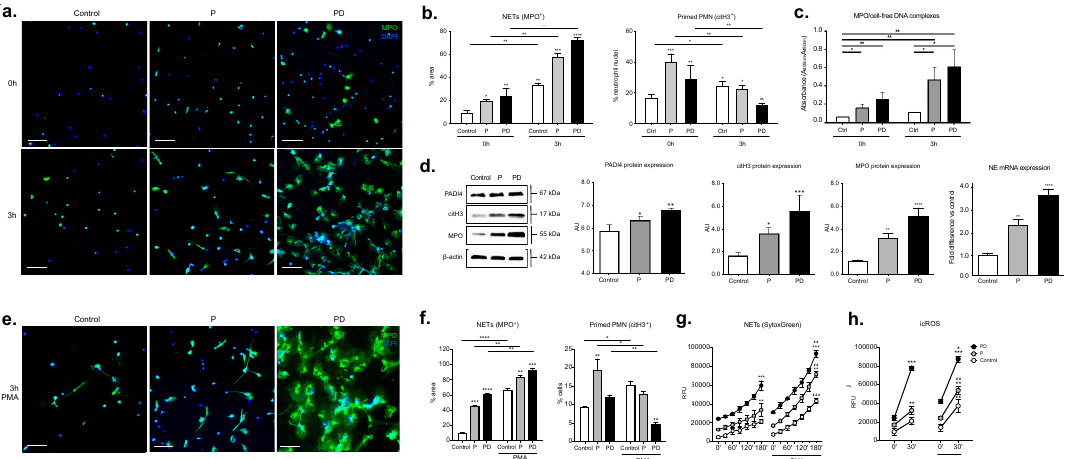
Figure 3. Postpartum circulatory neutrophils are prone to spontaneous in vitro NET formation and are hyperresponsive to pro-NETotic stimuli ( a ) Fluorescent immunohistochemistry for MPO (green), and DNA counterstain with DAPI (blue) at the baseline initial condition (0 h) and after 3 h in culture (3 h). ( b ) Morphometric analysis of the NETotic (MPO+) and pro-NETotic (citH3+) neutrophils from healthy donors, donors during pregnancy and postpartum. ( c ) Quantification of NETs-associated MPO/DNA complex levels in culture supernatants of neutrophils from healthy controls, donors during pregnancy and postpartum, at the steady state condition (0 h) and at the 3 h timepoint (3 h). ( d ) Western blot and densitometric analysis of PADI4, citH3, MPO and beta-actin protein expression levels in neutrophil lysates from healthy female controls, donors during pregnancy and 48 h postpartum; NE gene expression analysis by Taqman qRT-PCR in RNA samples obtained from healthy female controls, donors during pregnancy and 48 h postpartum. ( e ) Fluorescent immunohistochemistry for MPO (green), and DNA counterstain with DAPI (blue) at the baseline initial condition (0 h), after a 3 h culture (3 h). after incubation with the NET-inducing agent horbol-12-myristate-13-acetate (PMA) for a period of 3 h. Magnification: 20 × ; Scale bars: 50 µ m. ( f ) Morphometric analysis of the NETotic (MPO+) and pro-NETotic (citH3+) neutrophils from healthy donors, donors during pregnancy and postpartum. ( g ) in vitro spontaneous NET formation of neutrophils from healthy controls, donors during pregnancy and postpartum release in a 3 h timecourse by fluorimetric assessment. ( h ) Intracellular oxidative burst in neutrophils from healthy control donors, donors during pregnancy and postpartum by DCFH-DA detection. P: pregnancy; PD: post-delivery. Data are presented as mean ± SEM. * p < 0.05, ** p < 0.01, *** p < 0.001, **** p < 0.0001 (one-way anova followed by bonferroni’s multiple comparison post-test). All in vitro experiments were performed at least 6 times with consistent